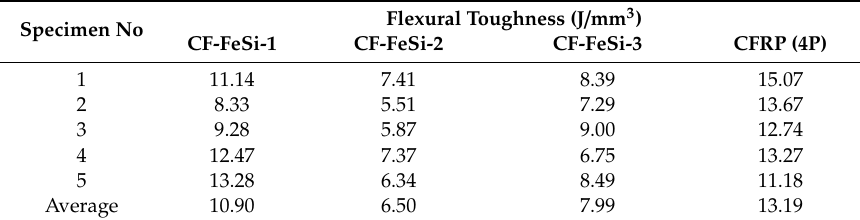
Table 6. Flexural toughness of the CFRP-FeSi composites.